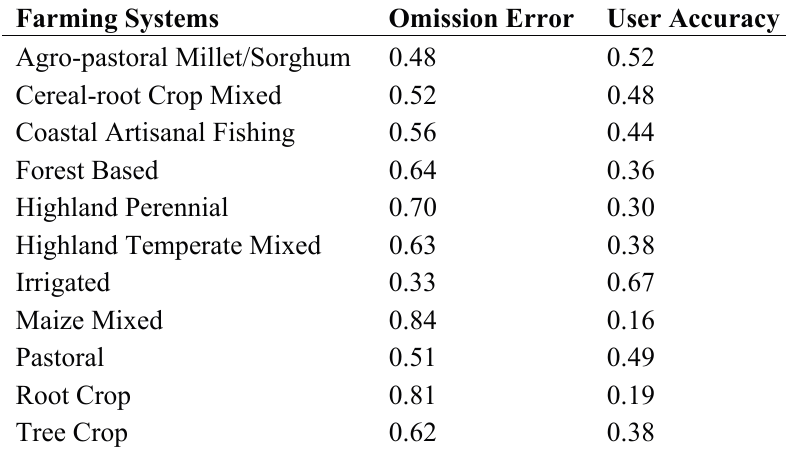
Table 3. Average omission error and average user accuracy estimated for major farming systems. The user accuracy is equal to 1—omission error.